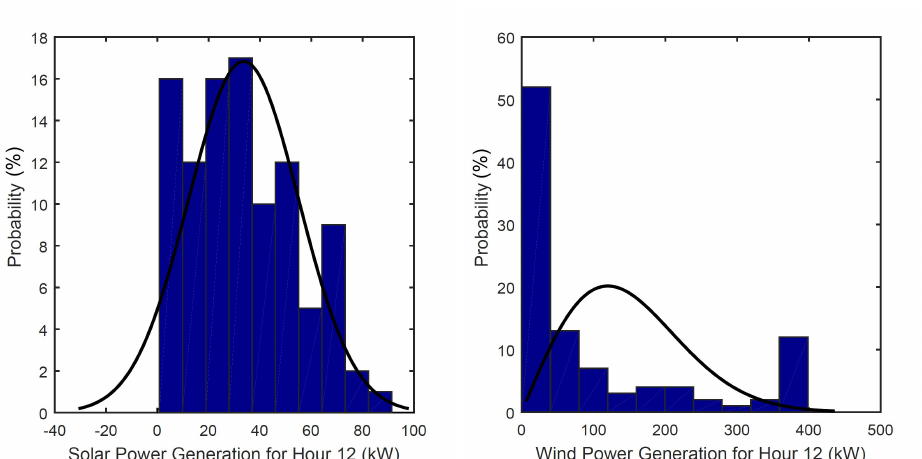
Figure 13. Probability of the power generation from solar PV ( left ) and wind ( right ) at the 12th hour on the 20 March case study.